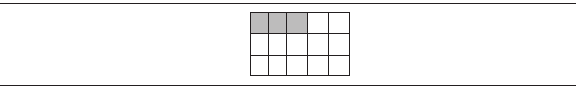
FIGURE 4: L6’s demonstration of Question 1.3(a). FIGURE 5: L17’s illustration for Question 1.3(a).